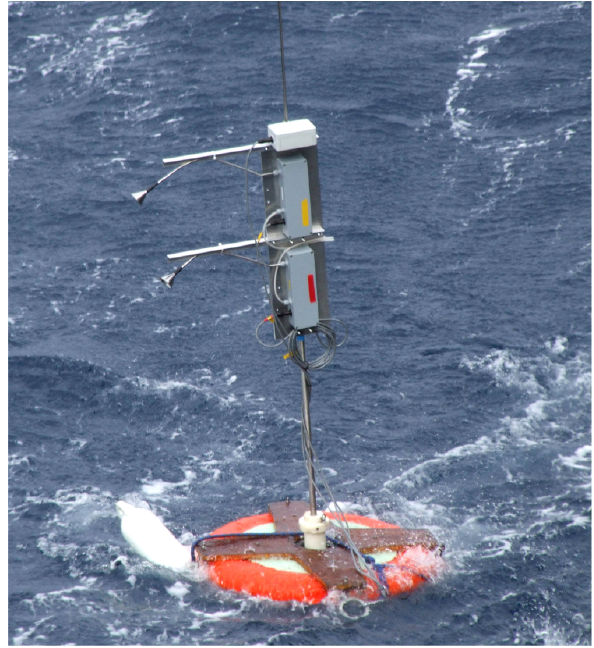
Fig. 1. The tethered buoy. The CLASP units are the two narrow grey boxes; their inlets are visible to the left. The lower unit was dam- aged and not used in subsequent deployments. The bubble imaging system is mounted below the buoy’s floatation